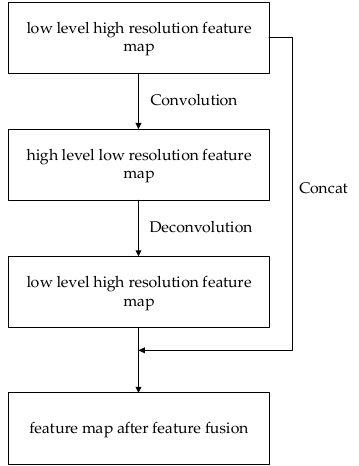
Figure 4. Feature fusion with deconvolution.